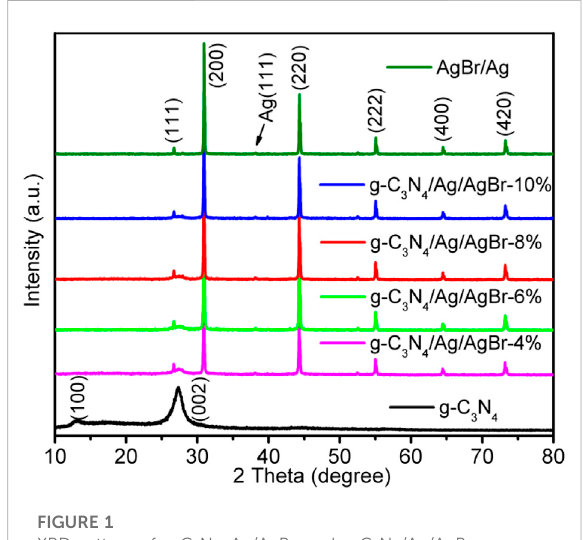
FIGURE 1 XRD pattern of g-C 3 N 4 , Ag/AgBr, and g-C 3 N 4